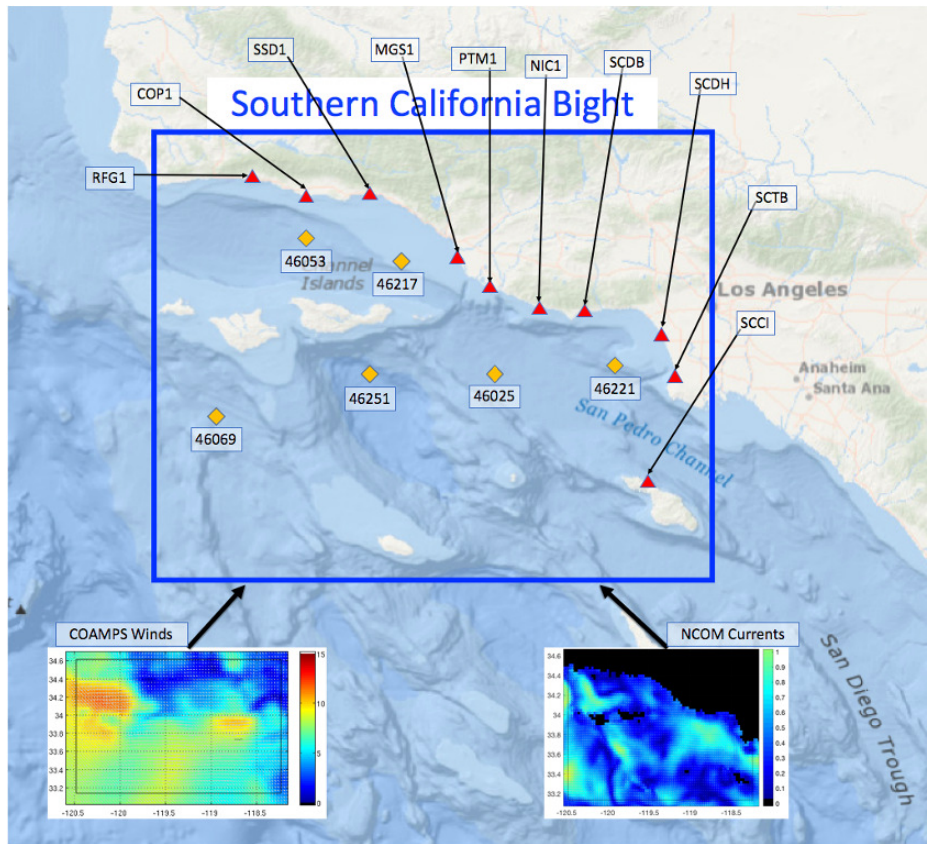
Figure 2. Map of the Southern California Bight with 10 HF radar sites (red triangles) and 6 NDBC buoys (orange diamonds). Example input fields for the SWAN wave model from COAMPS and NCOM are on the